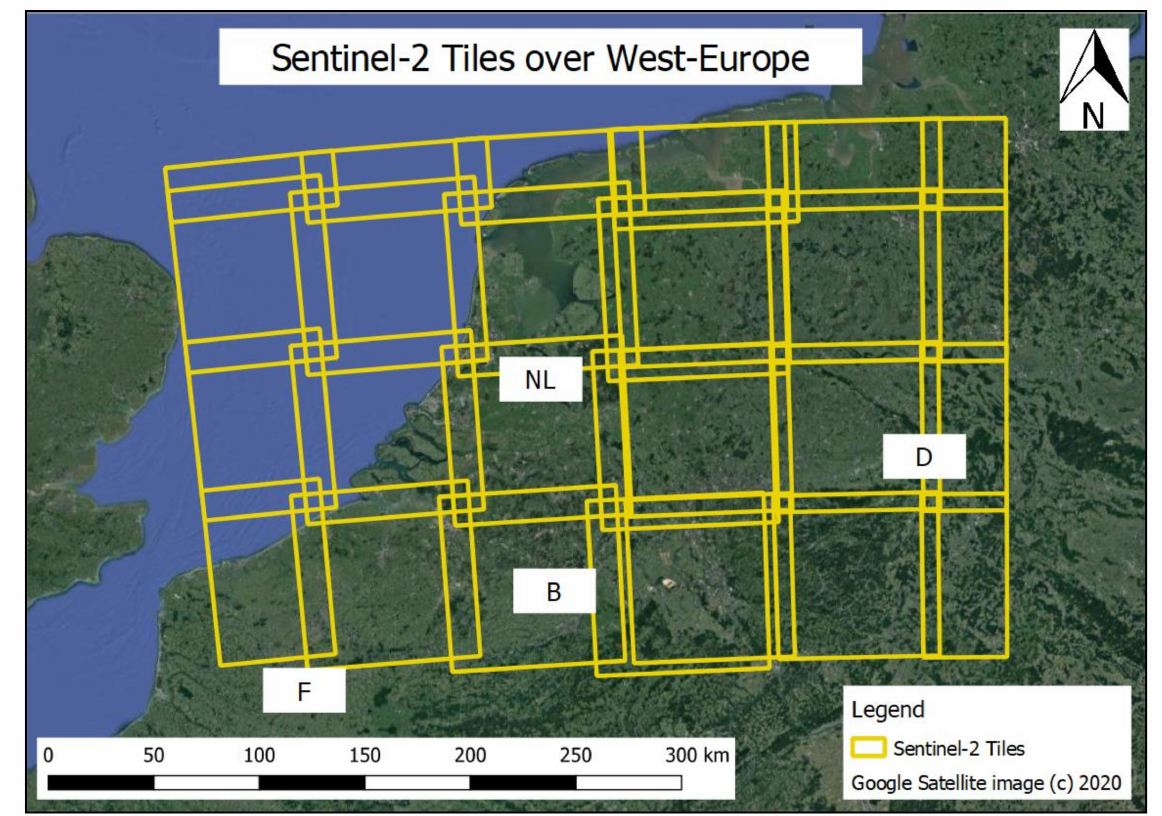
Figure 1. Extents of study area including all 28 Sentinel-2 tiles covering The Netherlands (NL), Belgium (B) and a part of France (F) and Germany